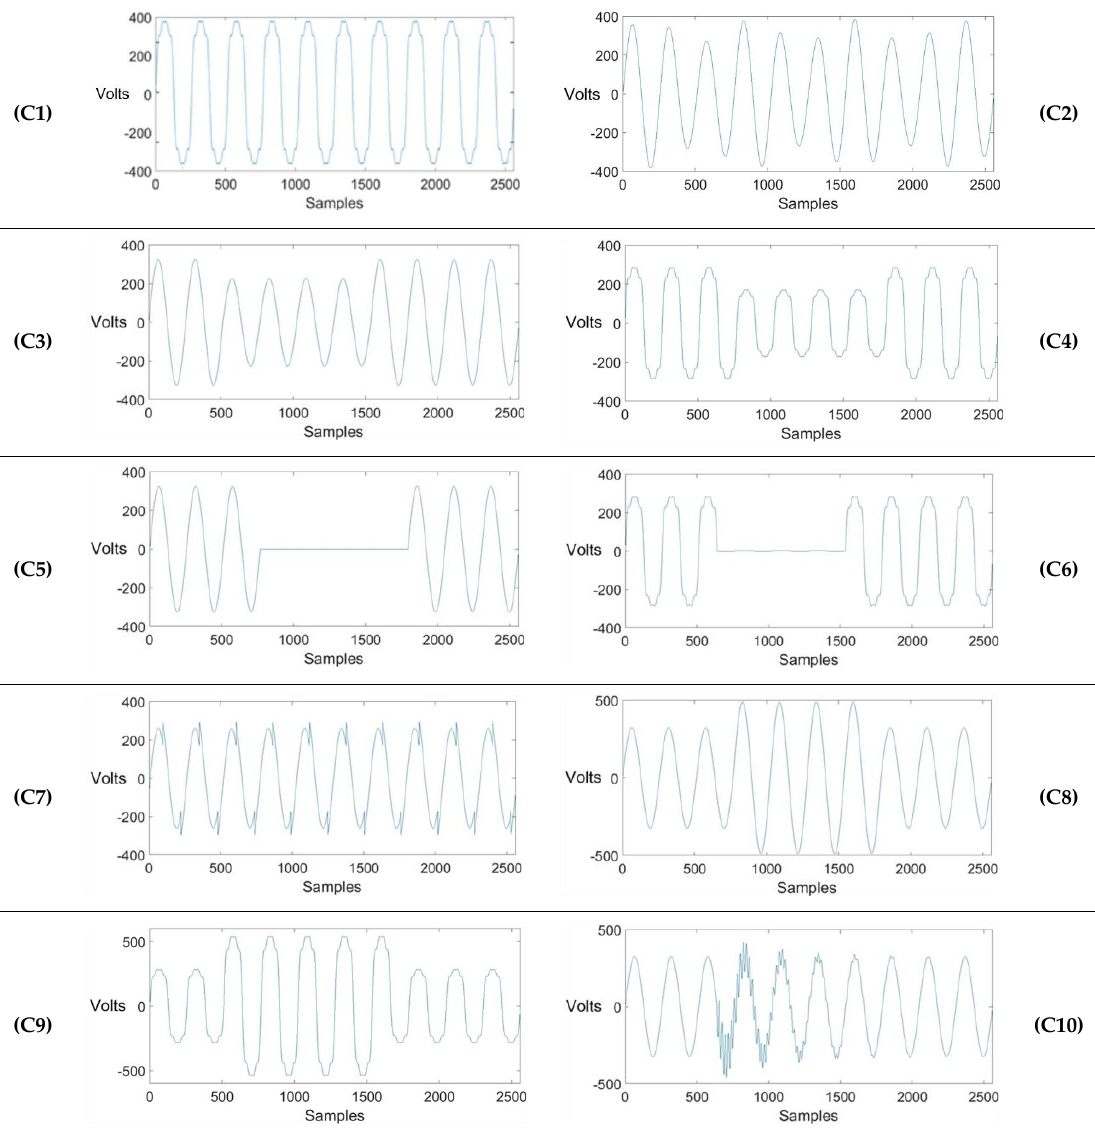
Table 2. Synthetized PQDs’ waveforms.